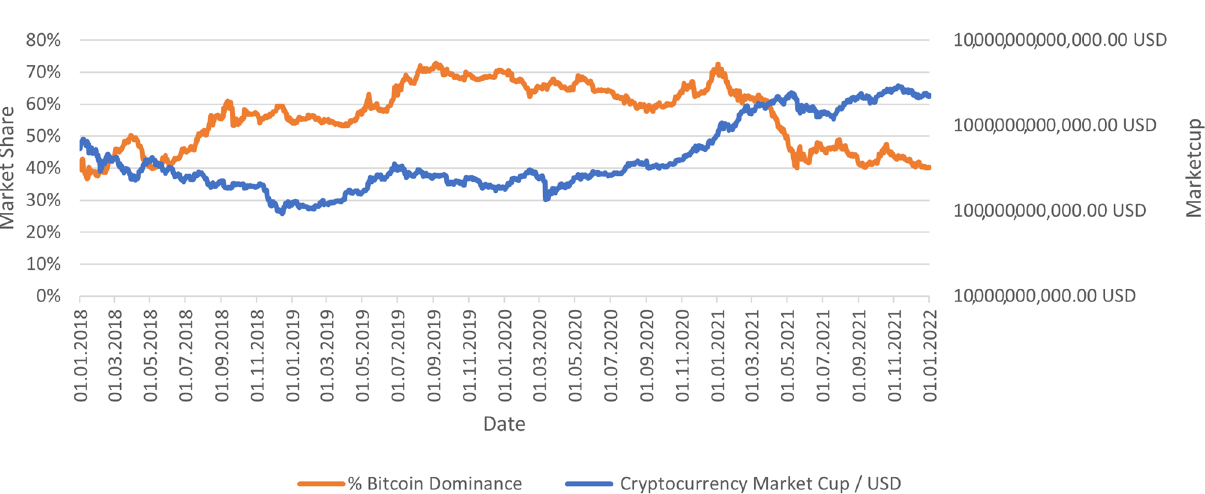
Figure 4. Cryptocurrency total market cup and Bitcoin dominance in the period under study.